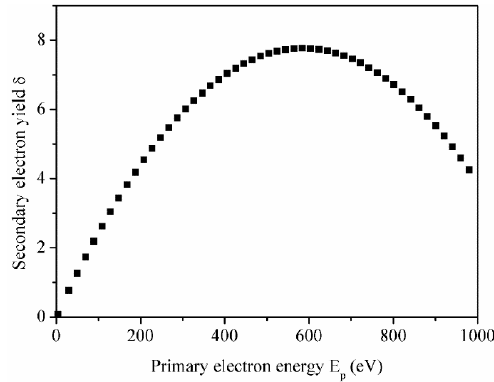
Figure 7. Typical SEE yield as a function of the primary electron energy for the Ag-2Mg-2Al alloy cathodes.